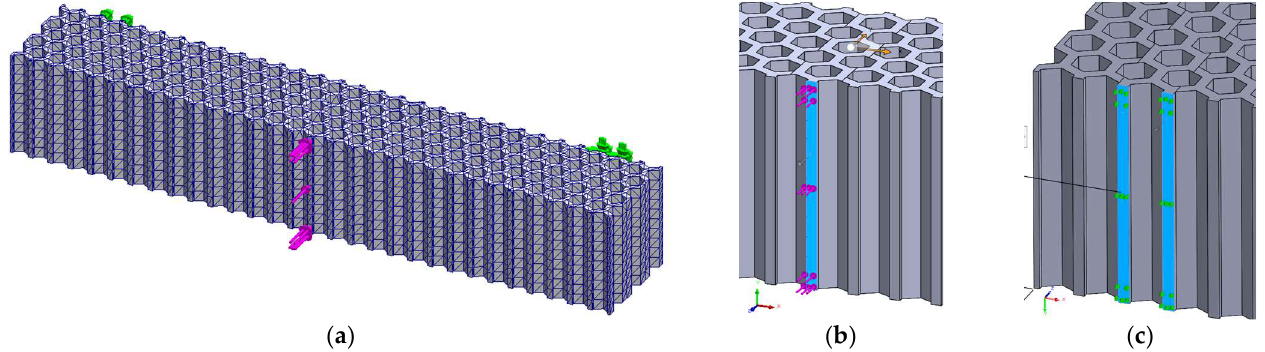
Figure 12. The FEM analysis setup for 3-point bending of the hexagonal structure—force applied along the Z -axis of the specimen: ( a ) general view, ( b ) detailed view of the loading force, ( c ) detailed view on fixing conditions (identically for both fixing areas).